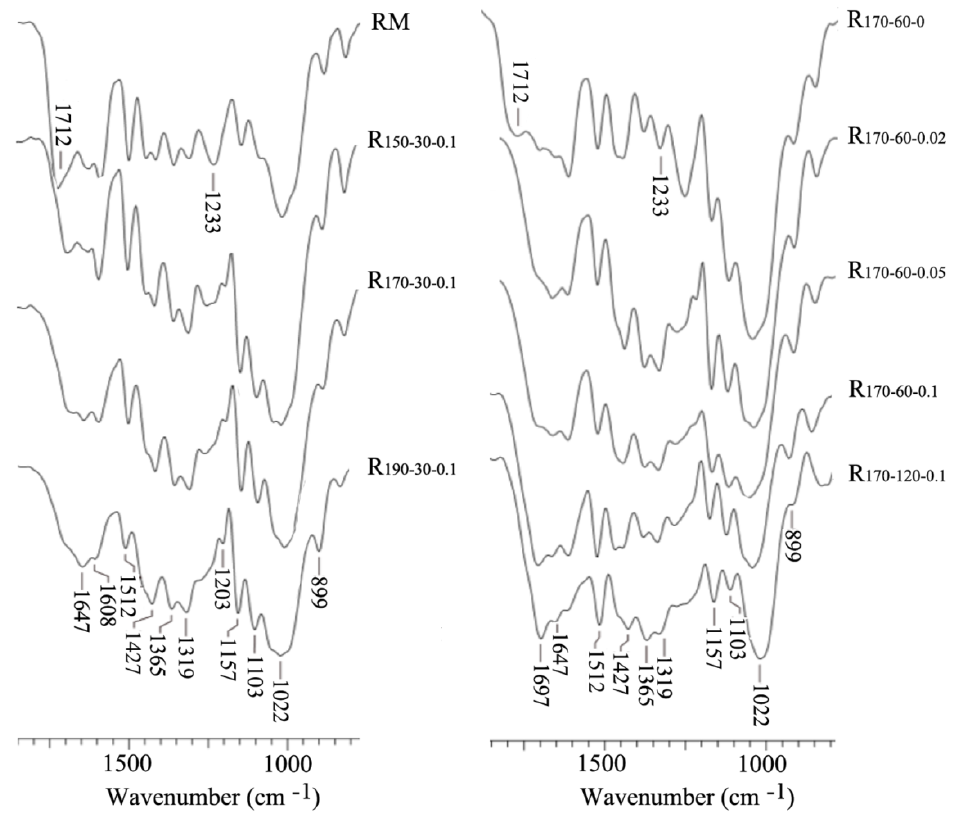
Figure 4. FT-IR spectra of the raw material and resulting solid residues with different systems.